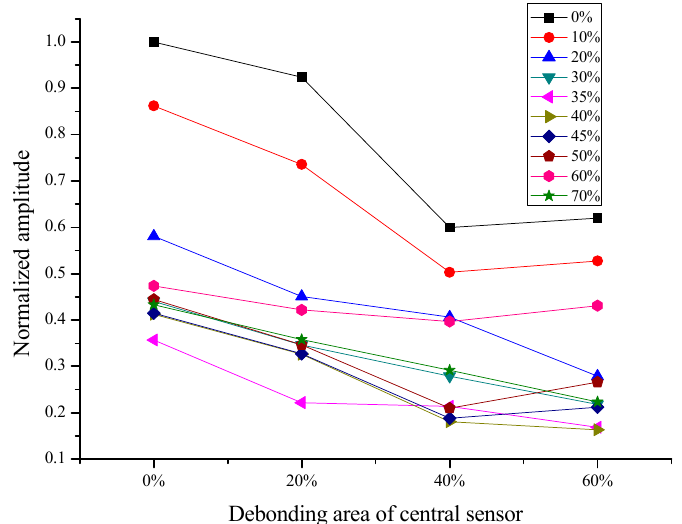
Figure 14. When the debonding area of the peripheral actuator is 0%, 10%, 20%, 30%, 35%, 40%, 45%, 50%, 60% and 70%, the changes of normalized amplitude of the signal with the increase of the debonding area of the central sensor, the excitation frequency is 50 kHz. Table 5. Combination of actuator and sensor with different debonding area.